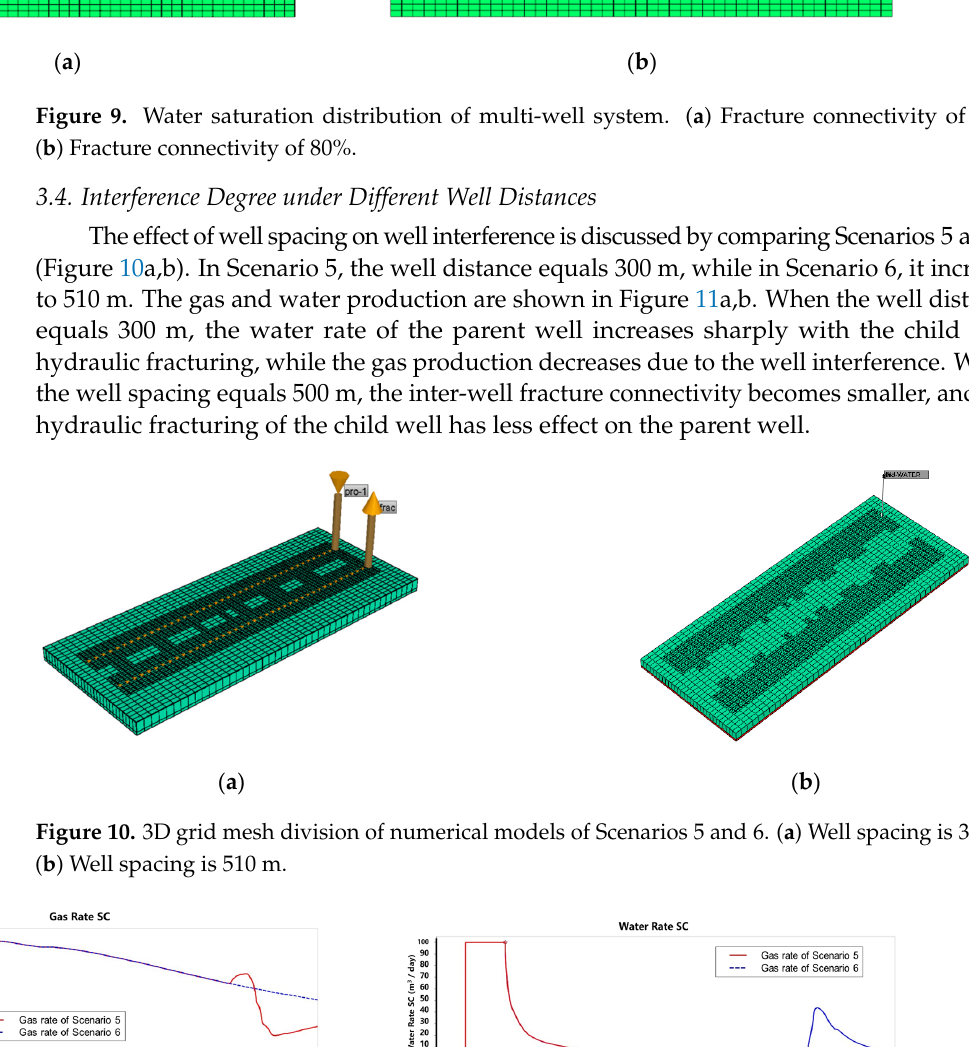
( b ) Figure 7. D grid mesh division of numerical models of Scenarios 3 and 4. ( a ) Fracture connectivity of 40%. ( b ) Fracture connectivity of 80%.